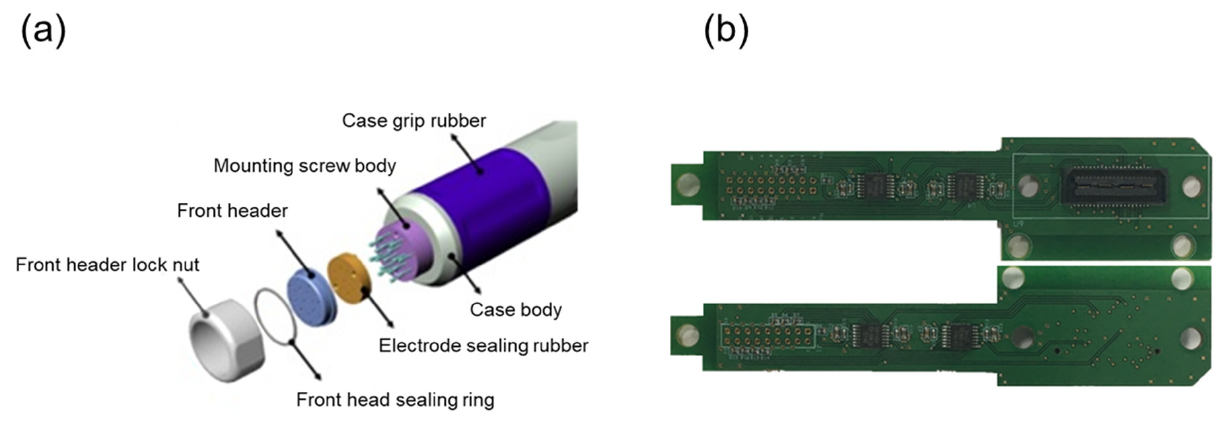
Figure 2. Illustration of the multi-electrode screening probe: ( a ) Case design and ( b ) Multi-layered signal processing board.